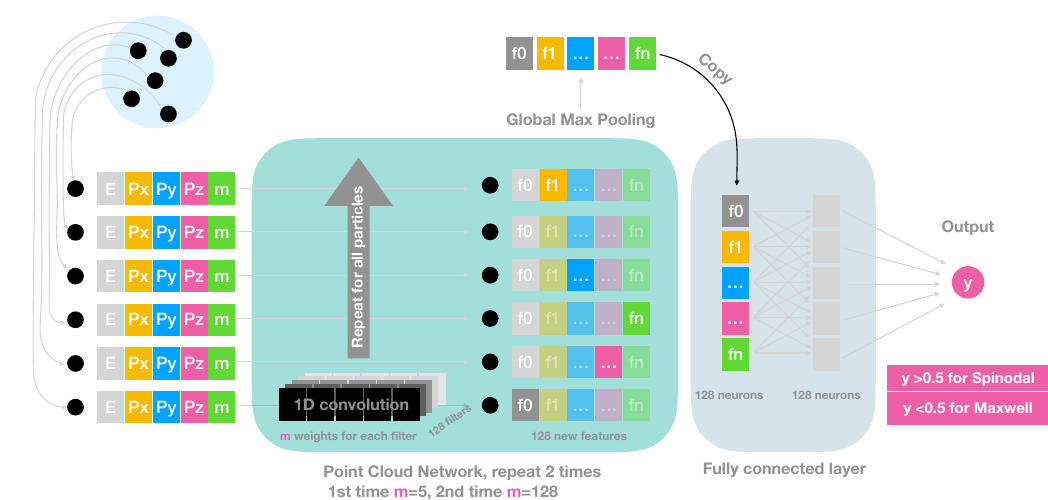
Figure 14 . Structure of the Point Cloud Network used in this